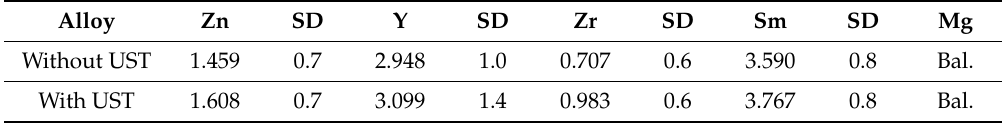
Table 2. The average contents of main solute elements within grains (wt %).